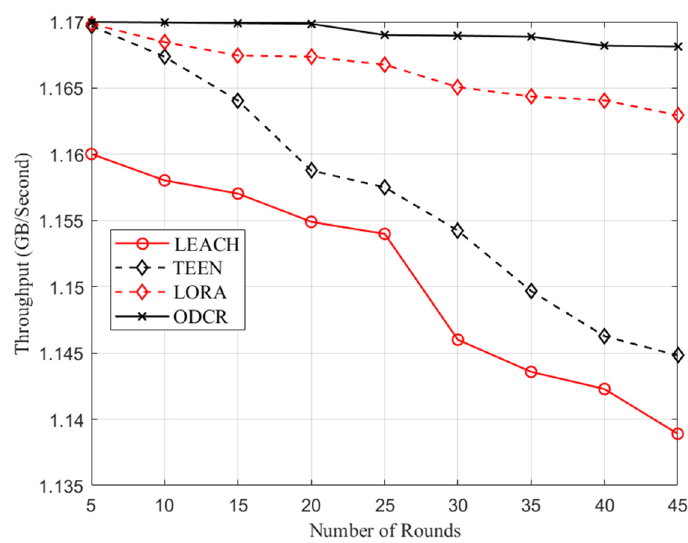
Figure 10. Comparison of throughput.